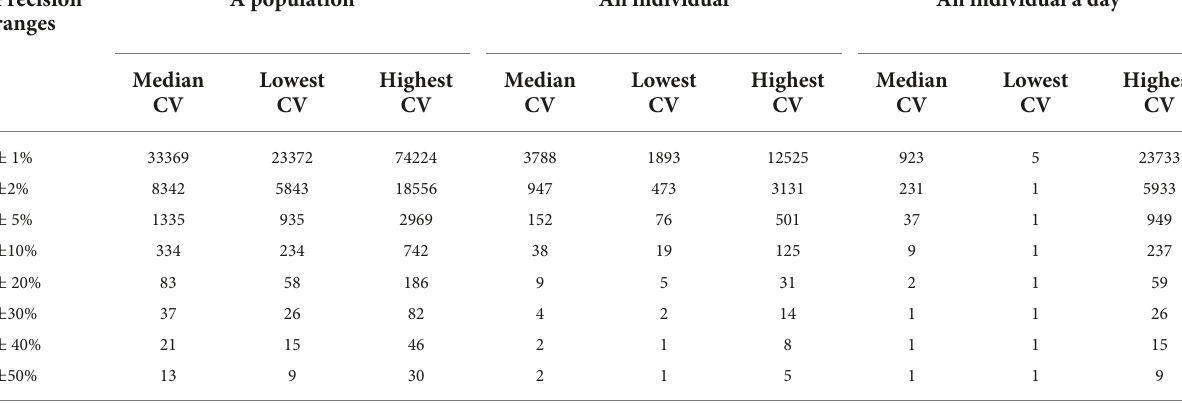
TABLE 6 Number of samples needed to be 95% confident of being within a specified range for estimating the breast milk iodine status. Precision